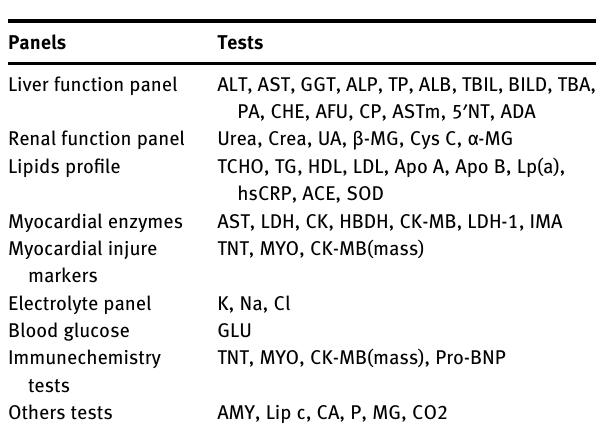
Table  : Liver function panel, renal function panel, lipids pro fi le, myocardial enzymes, blood glucose and others tests were belong to clinicalchemistrytestsandtestedinc  orc  clinicalchemistry